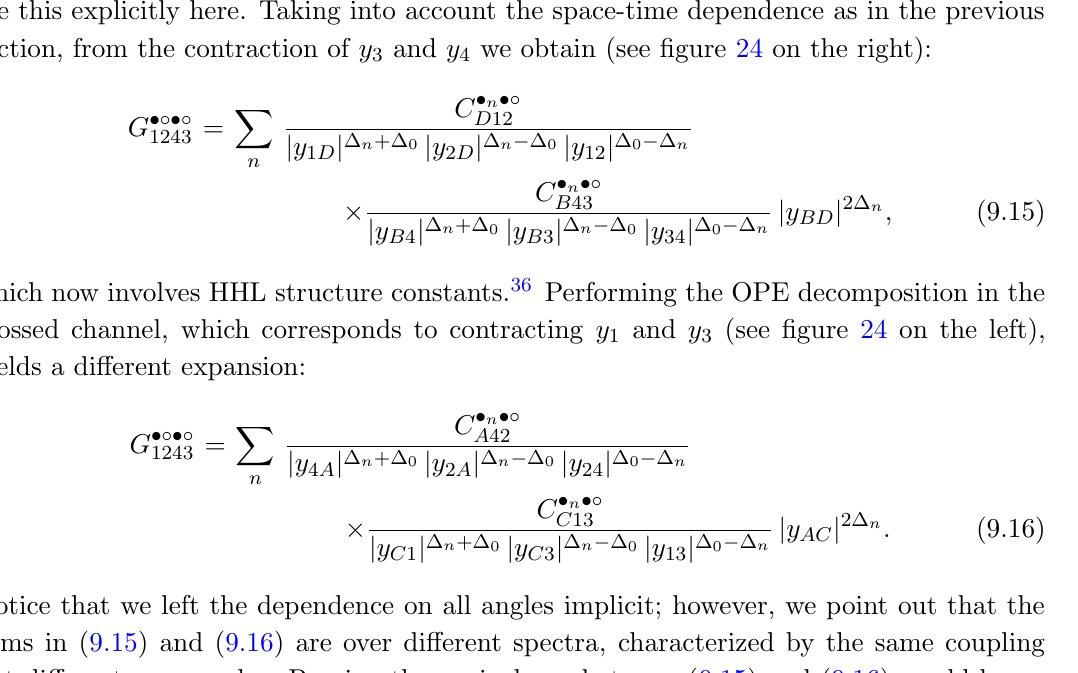
sides A B C of the Wilson loop, are traded for a sum over excitations of a single cusp at the point D , de(cid:12)ned by the extension of the lines A and C